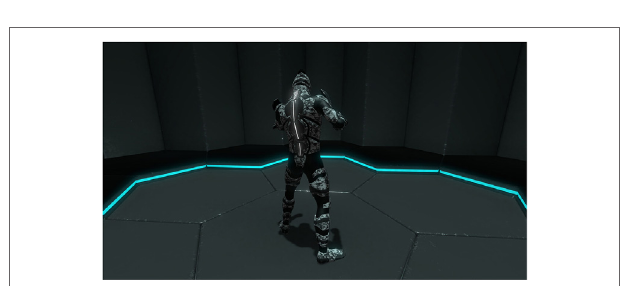
FigUre 3 | Virtual character seen from a third-person perspective (3PP) during the appropriation phase and controlled by the users thanks to the motion capture